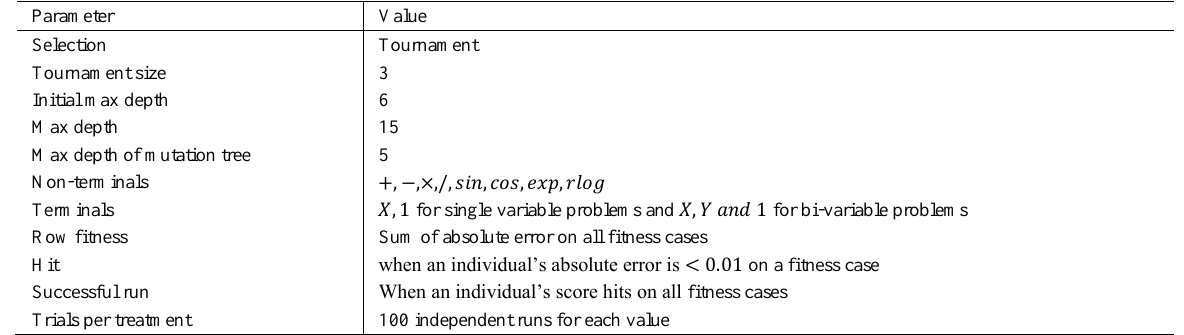
Table 2. Main parameters of